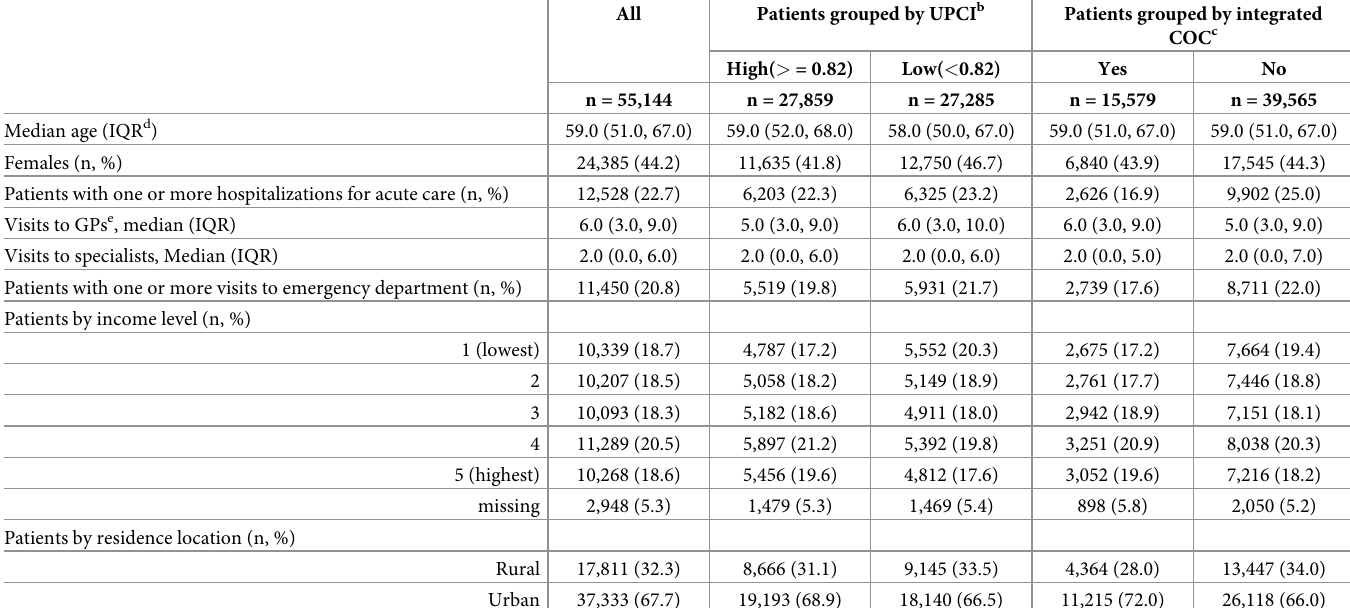
Table 1. Baseline characteristics a of the final cohort.